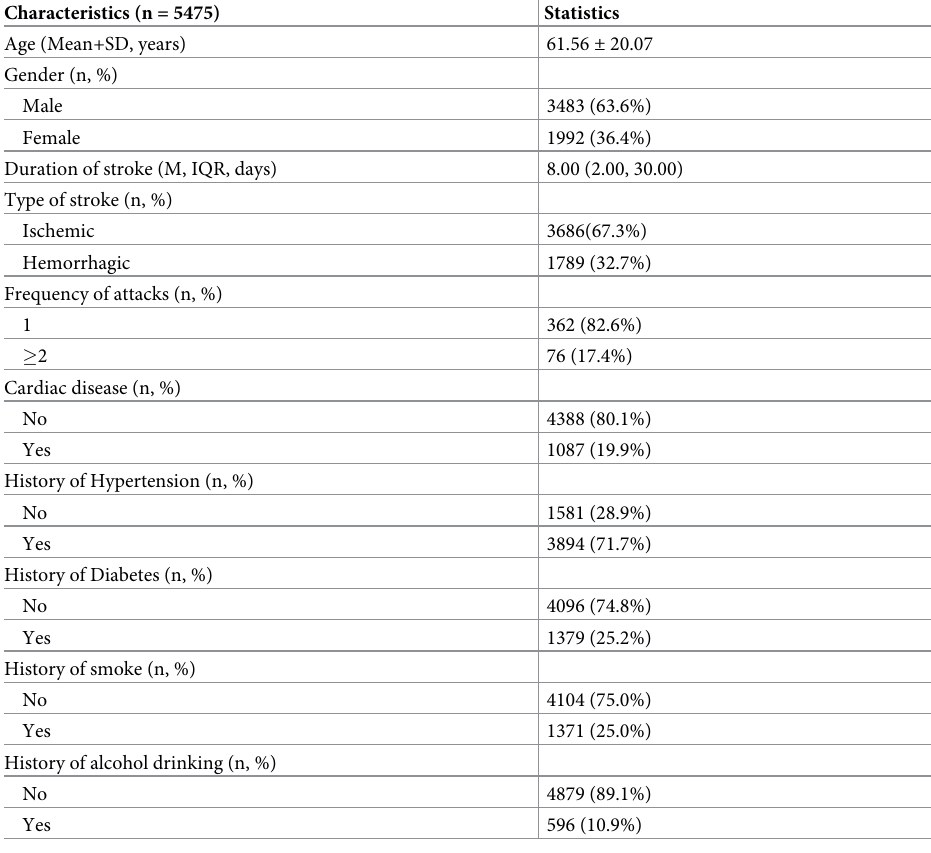
Table 1. Clinical characteristics of stroke